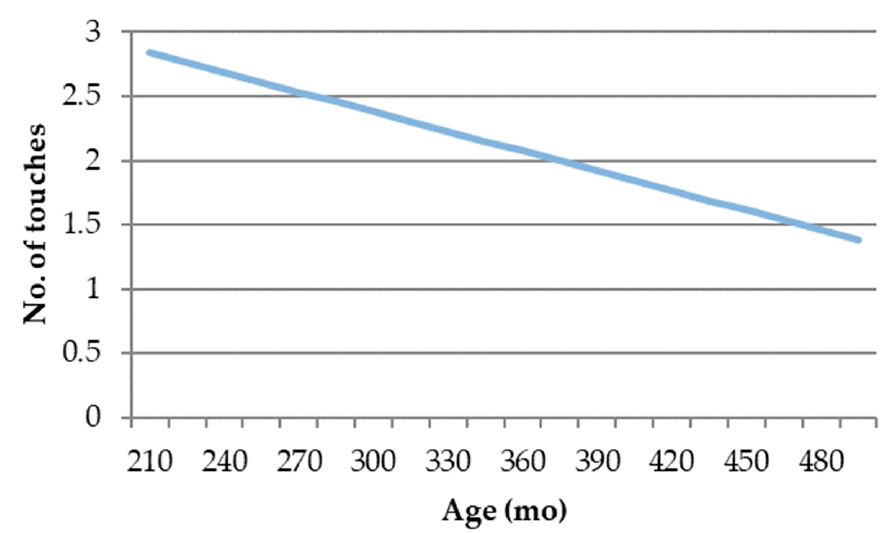
Scheme 2. E ff ect of touch latency on the number of